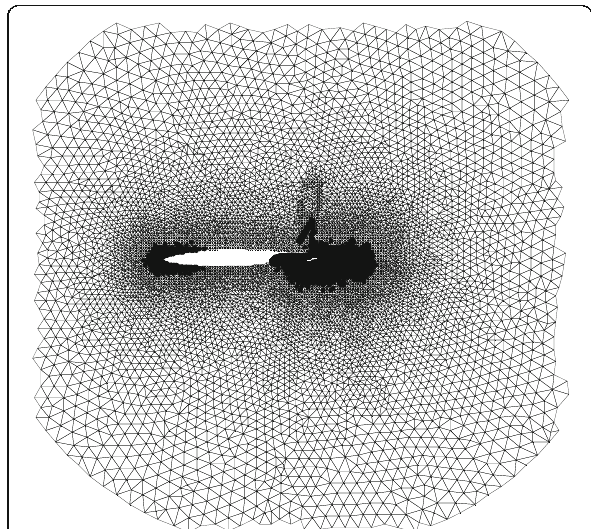
Fig. 15 Local meshes for multi-element